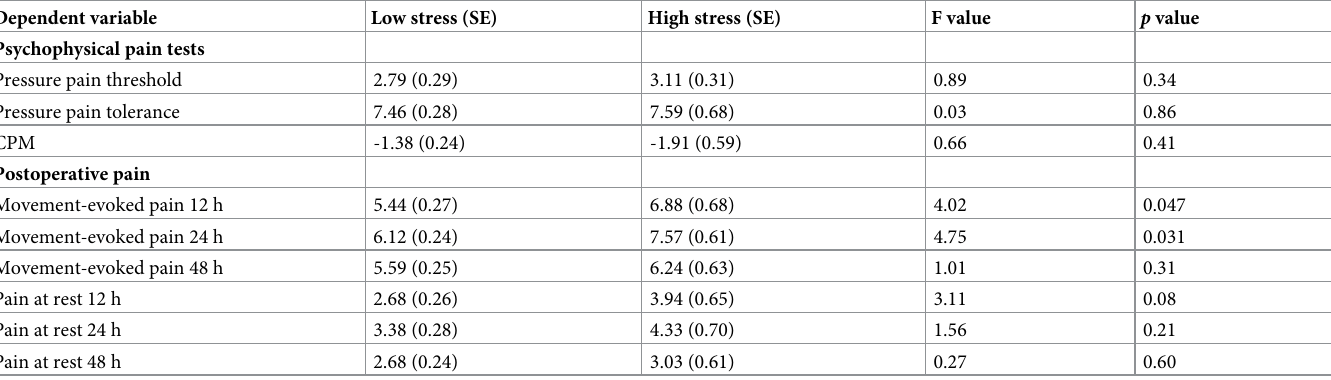
Table 5. MANCOVA model for pre- and postoperative pain variables comparing low or high psychological stress according to B-MEPS tool � . Dependent variable